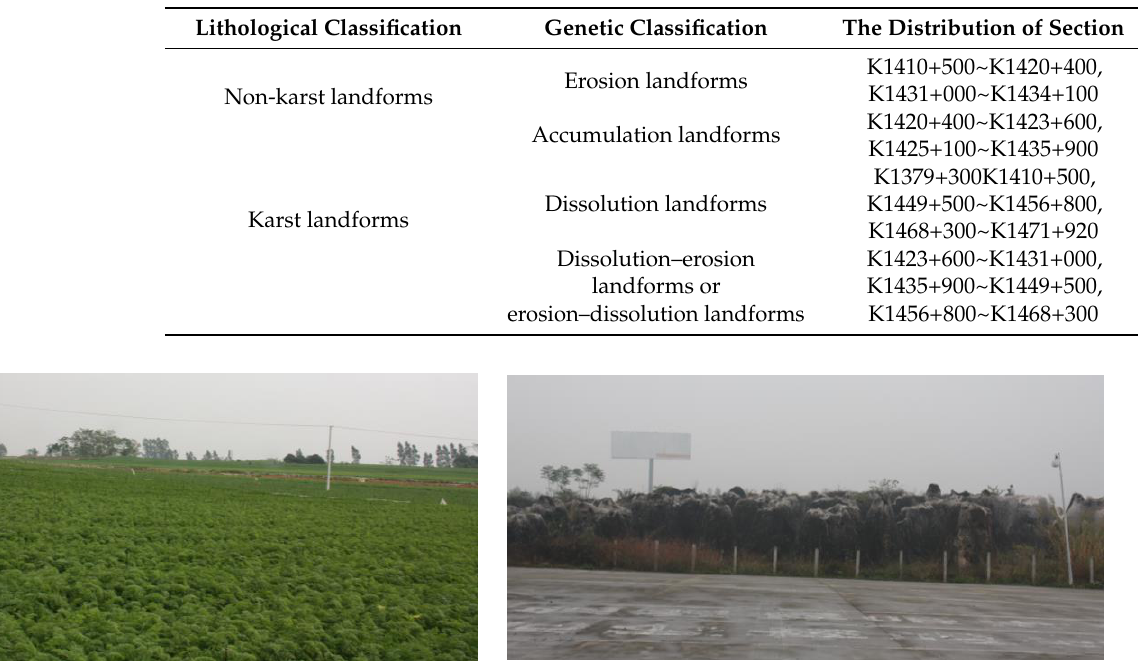
Table 2. List of landform types in the study area.